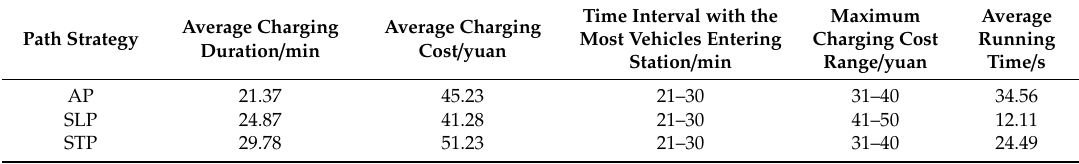
Table 2. Evaluation indexes of charging station navigation for each route strategy.